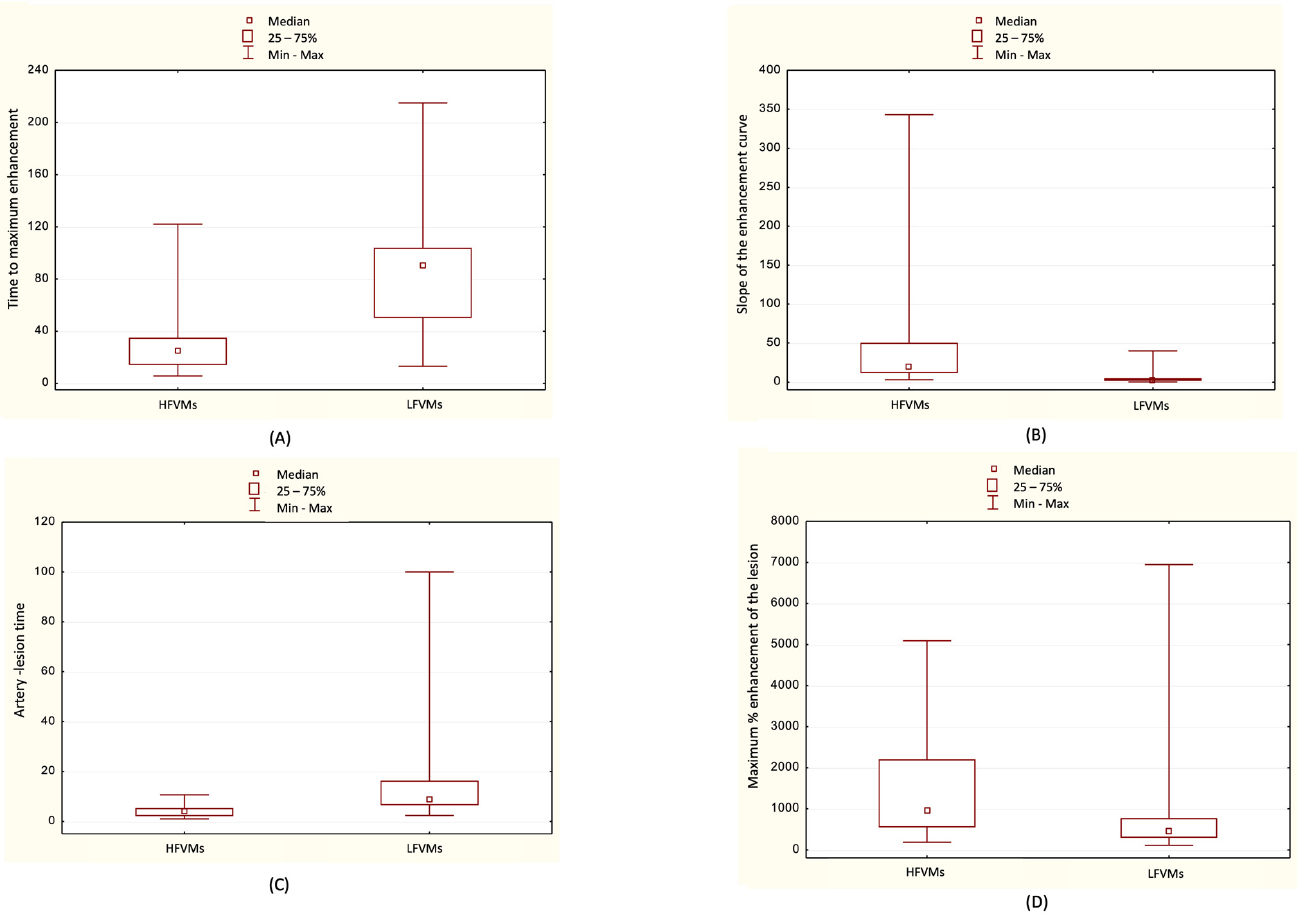
Figure 4. Box plots of calculated ratios according to the hemodynamic characteristics of vascular malformations (VMs). ( A ) Time to maximum enhancement. ( B ) Slope of the enhancement curve. ( C ) Artery-lesion time. ( D ) Maximum percentage enhancement of the lesion. HFVMs—high-flow vascular malformations, LFVM—low-flow vascular malformations. Lower and upper box boundaries 25th and 75th percentiles, respectively, square inside box median, lower and upper error lines minimum and maximum,